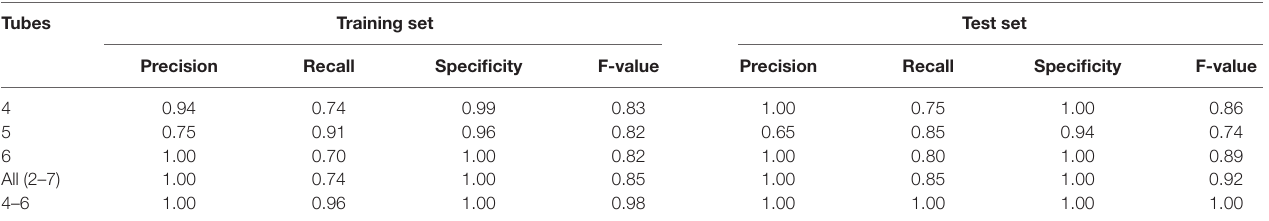
The statistical measures are computed for each tube separately and two combinations of